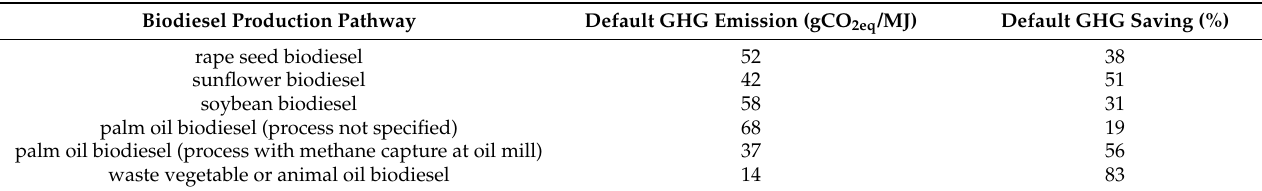
Table 2. GHG emission value and emission reduction in relation to fossil fuel analogue throughout the lifecycle of biodiesel, taking into account the type of raw material [73].